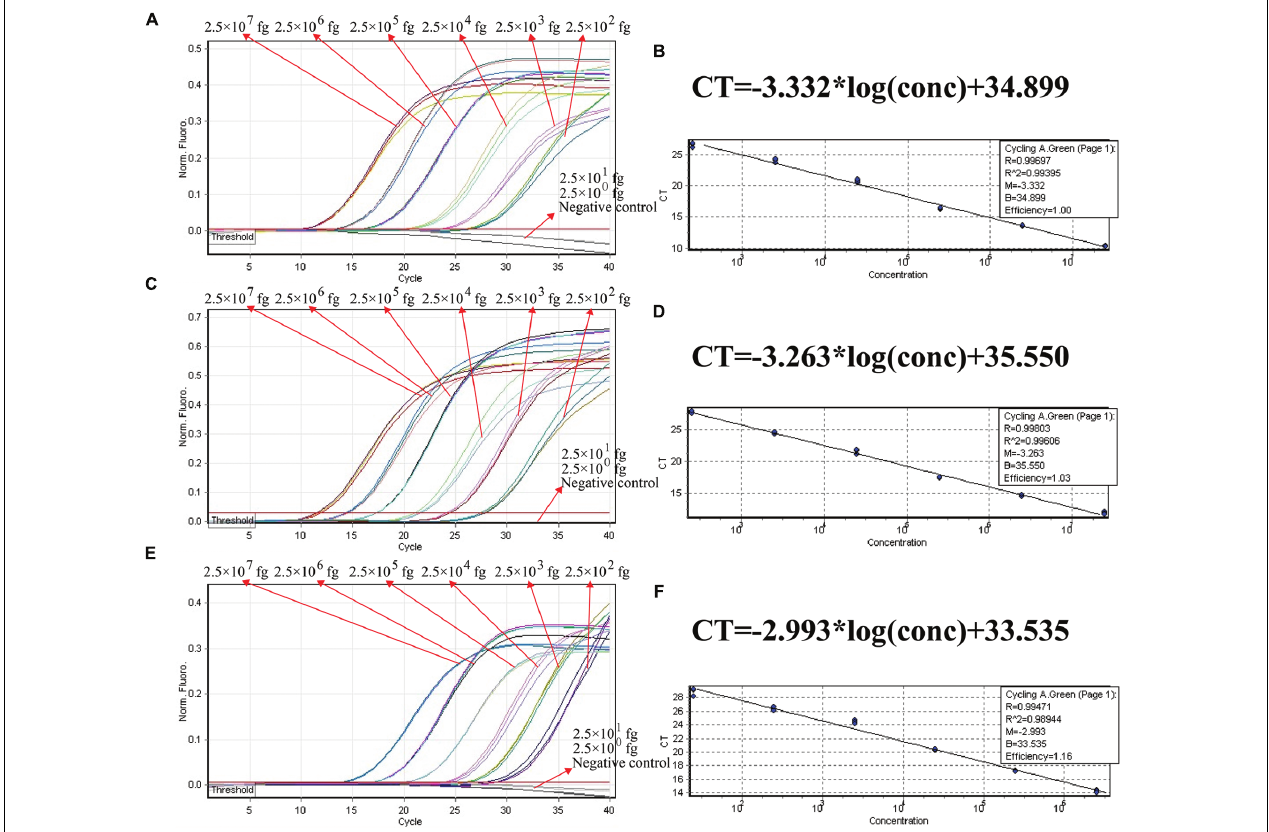
FIGURE 5 | The analytical sensitivity of conventional qPCR (SYBR Green) assay for detecting a single target. Three sets of conventional qPCR primer targeting ply , nuc, and Ef0027 genes were in different reactions: S. pneumoniae (A) , S. aureus (C) , and E. faecalis (E) . The DNA levels from 2.5 × 10 7 to 2.5 × 10 2 fg per tube provide the positive signals, 2.5 × 10 1 and 2.5 × 10 0 fg per reaction and negative control generate negative signal. ( B; S. pneumoniae ), ( D ; S. aureus ), and ( F ; E. faecalis ), C t was plotted against the sample DNA concentration (fg) of the